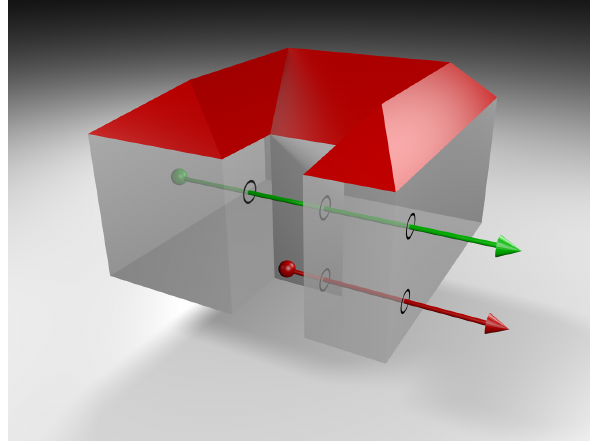
Figure 1: Basic point-in-polyhedron test with the raytracing ap- proach. By counting the number of intersections of a ray starting from a point with all faces the inside/outside decision is made. The green ray intersects an uneven number of intersecting faces and thus the starting point of this ray is considered as lying inside the building. The red ray has an even number of intersections with the faces and thus the starting point is considered being out- side the building.